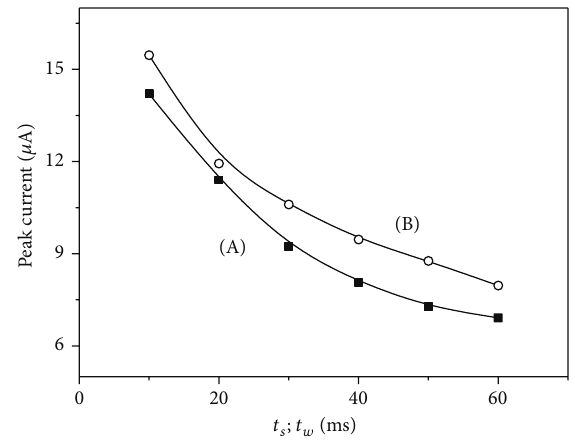
Figure 2: Dependence of the codeine peak potential on ln of scan rate in the range from 10 to 500 mVs −1 for 50 𝜇 M codeine in 0.1M phosphate buffer (pH 3.0).